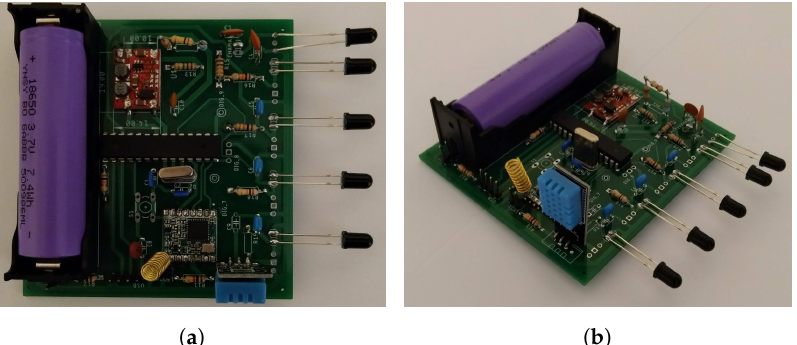
Figure 6. Developed sensor module 5FTH. ( a ) Developed PCB with the components (Top view); ( b ) Developed PCB with the components (Side